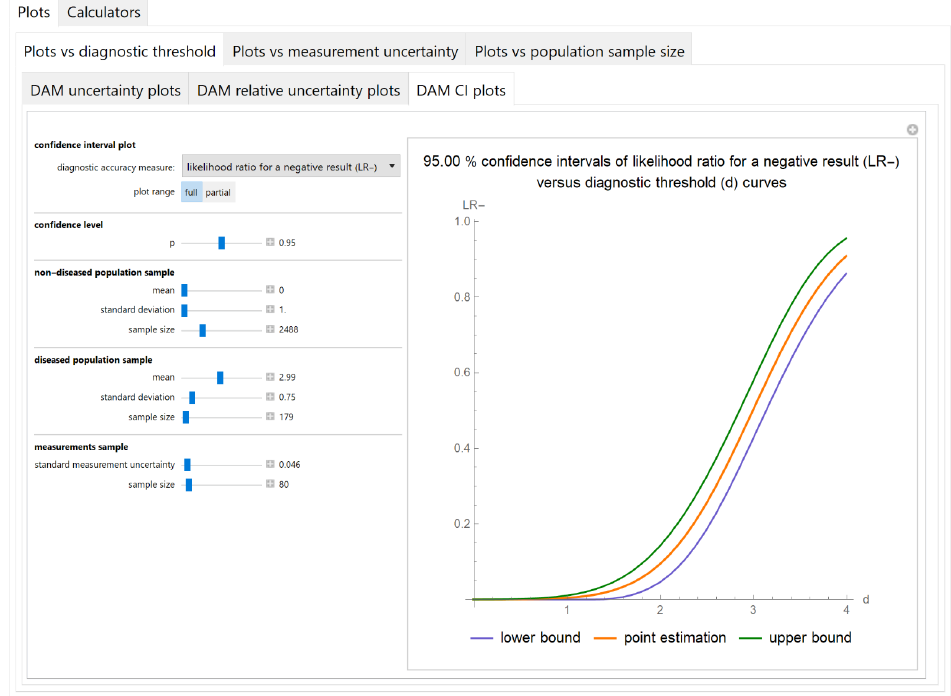
Figure 5. Plots vs. diagnostic threshold module, DAM CI plots submodule screenshot. Confidence intervals of likelihood ratio for a negative test result ( LR - ) versus diagnostic threshold ( d ) curves plot, with the settings shown on the left. The respective parameter settings are also shown in Table 3. Diagnostic Accuracy Measures Standard Uncertainties Plots Submodule The values of the standard combined, measurement and sampling uncertainties of diagnostic accuracy measures of a screening or diagnostic test are plotted versus the meas- urement uncertainty of the test (Figure 6).